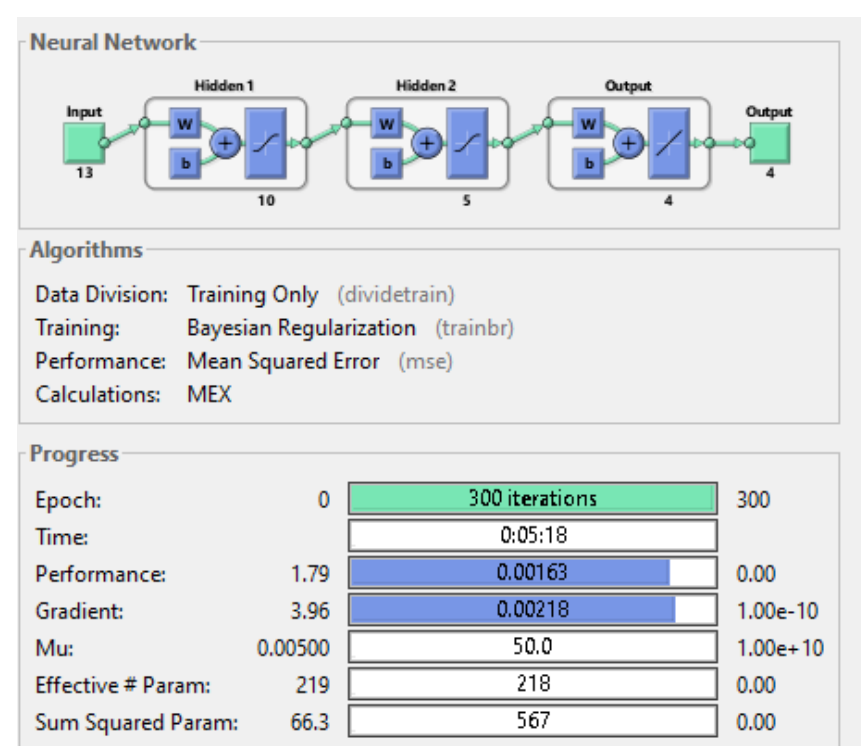
Figure 10. Detailed implementation of ANN flux estimator.